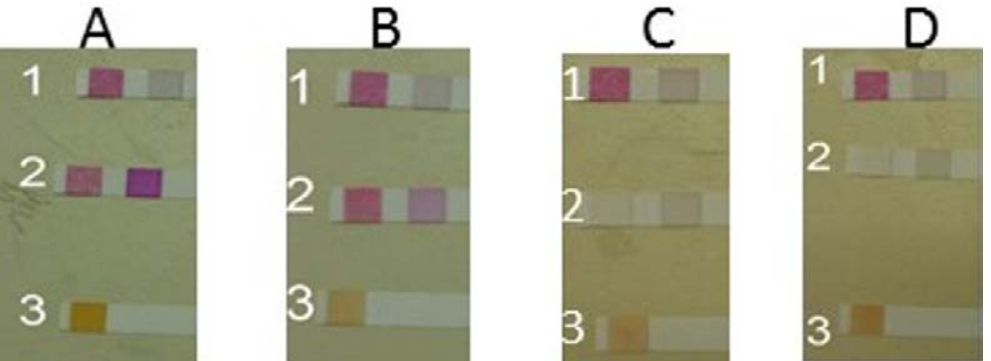
Fig . 2 A . Strip (1) control for nutrient media for detection NO3/NO2. Strip (2) Moderate reduction by P. stutzeri for NO3/NO2. (3) P. stutzeri strep detected NO2. B. (1) Control for Mineral media strep for detection of NO3/NO2. (2) Moderate reduction by P.stutzeri strep for NO3/NO2. (3) P.stutzeri strep for detection of NO2. C . (1) Control for nutrient media strep for detection of NO3/NO2. (2) Full reduction by P. aeruginosa strep for NO3/ NO2. (3) P. aeruginosa strep for detection of NO2. d . Control for Mineral media strep for detection of NO3/NO2. (2) Full reduction by P. aeruginosa strep for NO3/ NO2. (3) P. aeruginosa strep for detection of